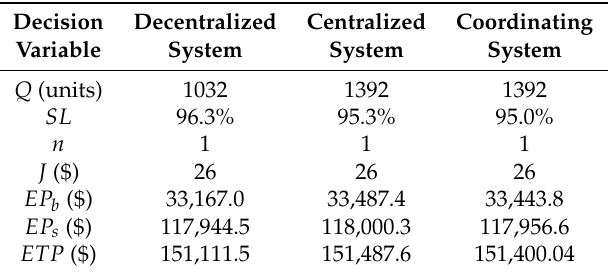
Table 5. Output data for numerical problem 2, in the case of a reliable